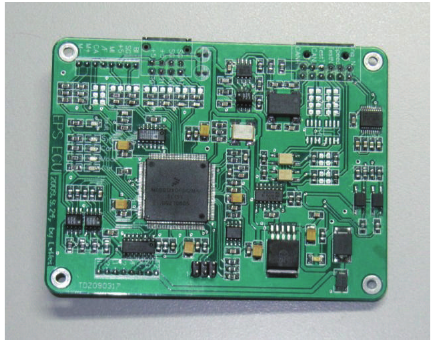
Figure 4: EPS controller for the test.